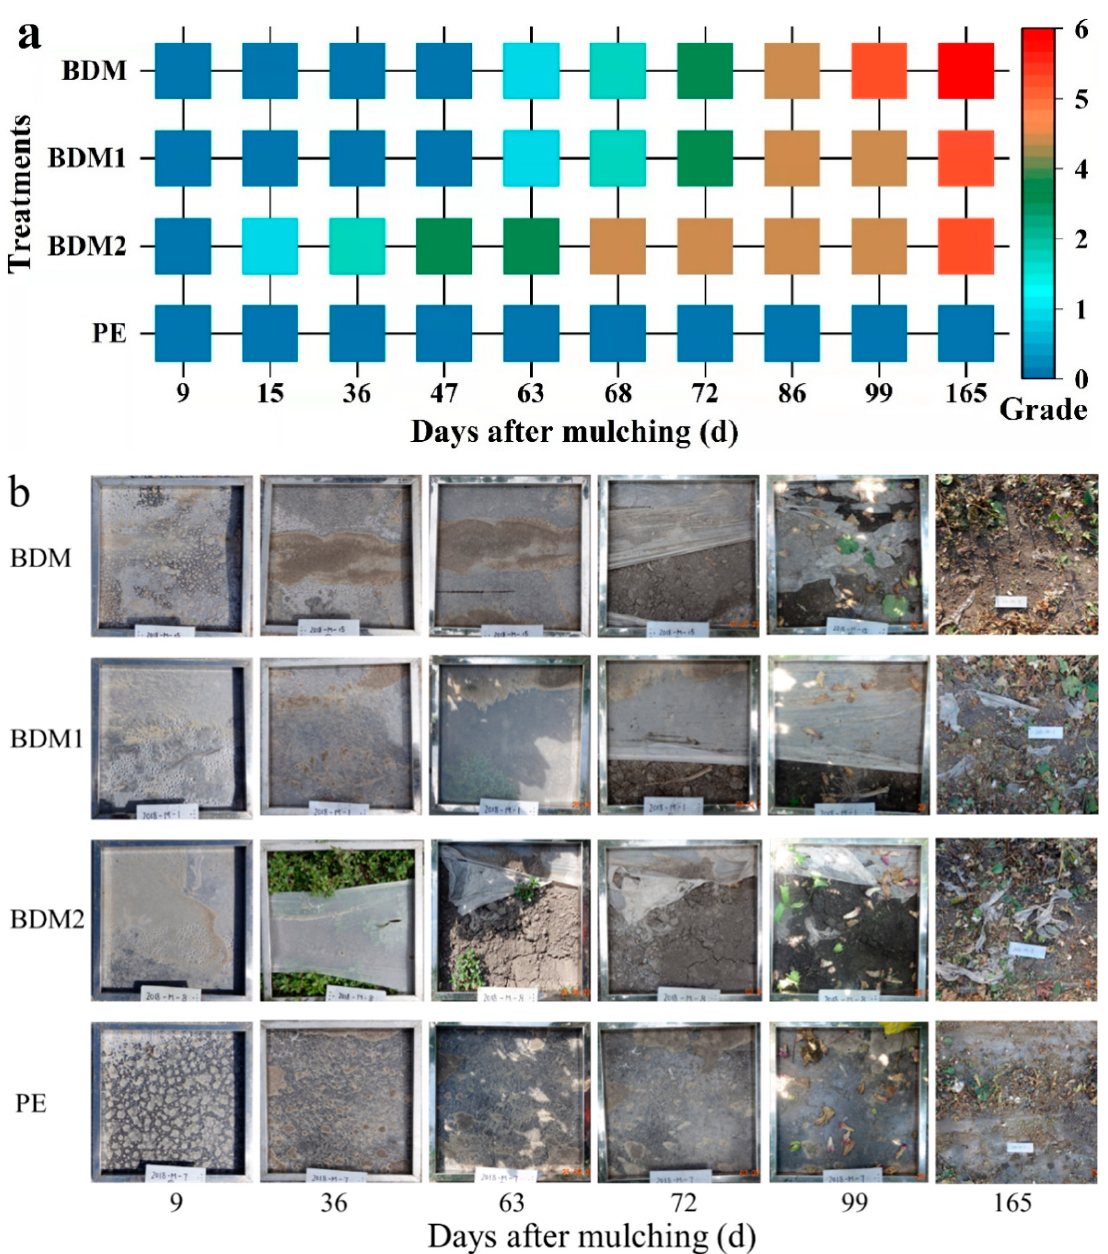
Figure 6. Degradation grading ( a ) and digital photos ( b ) (side length of the metal frame is 50 cm) of BDM, BDM1, BDM2, and PE films along with mulch duration and after harvest (165 days).